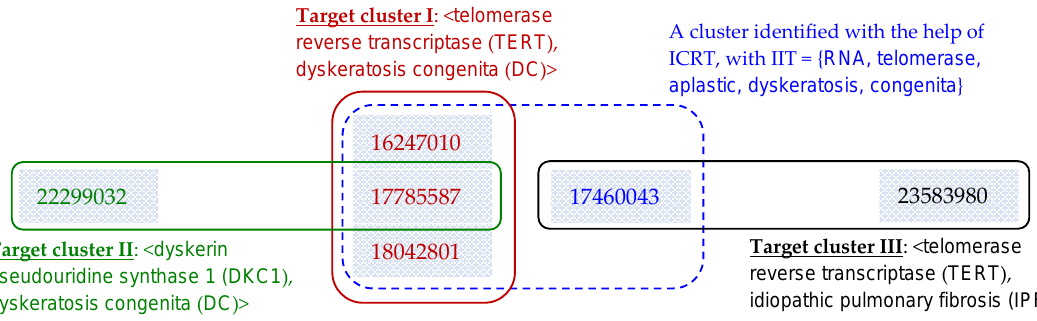
Figure 7. A case study to analyze how ICRT successfully improves clustering systems that work on various inter-article similarity measures: Without ICRT, all the underlying systems make more errors (see the explanation in the main text).